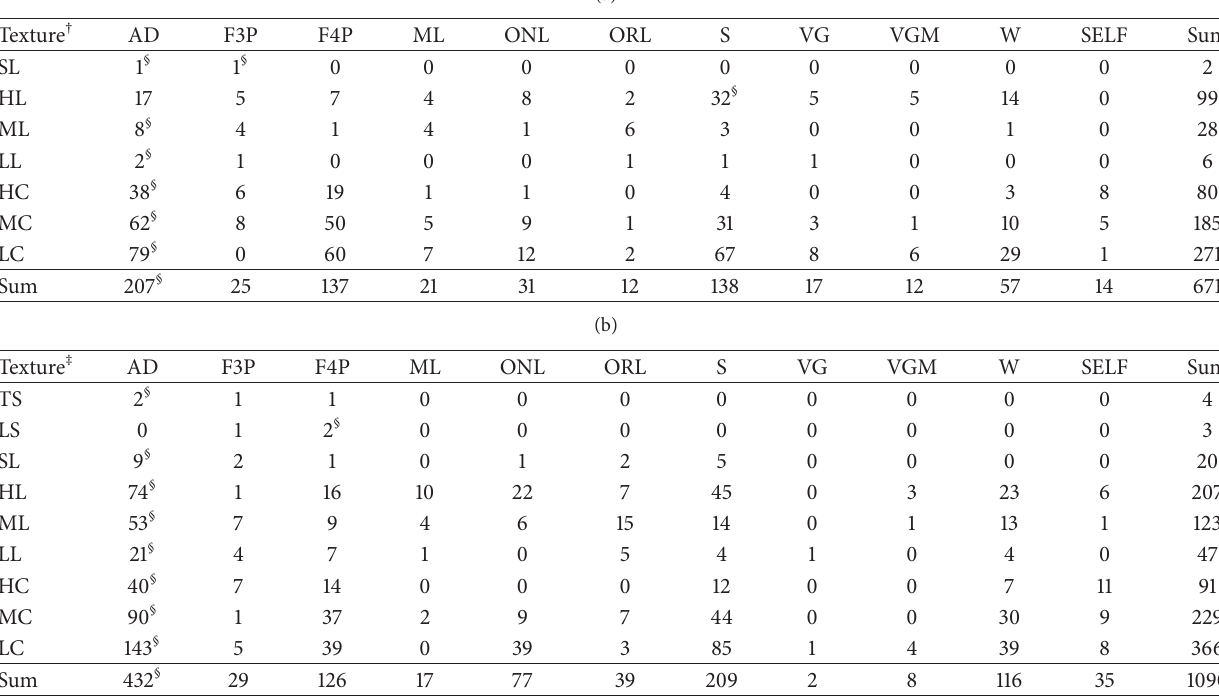
Table 4: Number of cases as the best model with the smallest AIC value for each soil textural class in T2 (a) and T3 (b) schemes †